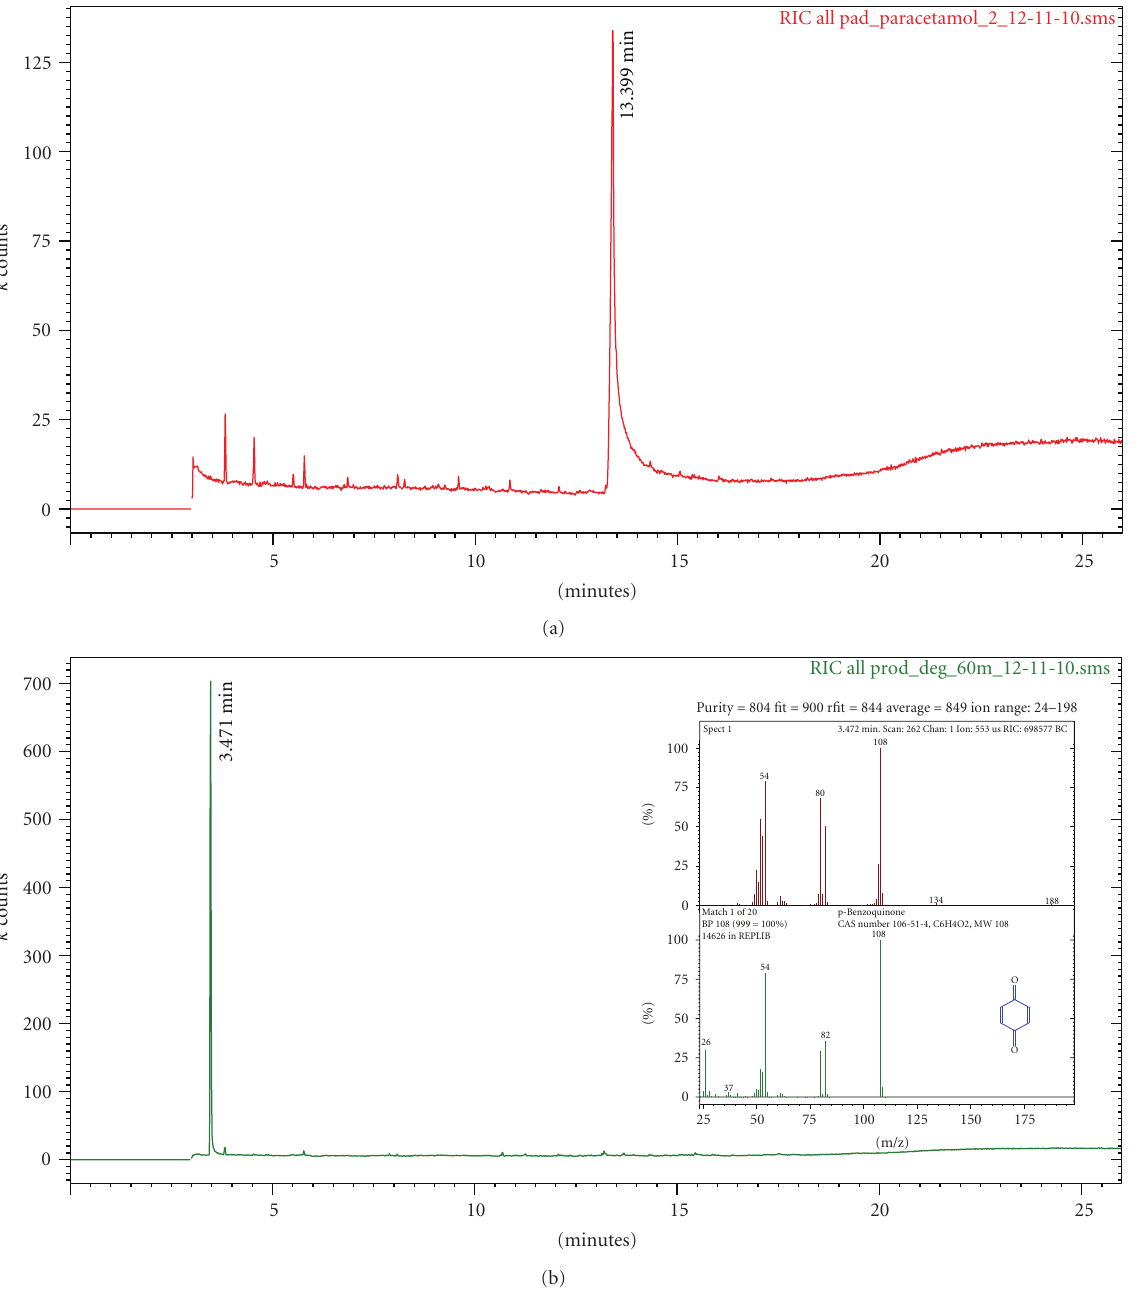
Figure 9: (a) GC chromatogram obtained for standard paracetamol solution in dichloromethane. C paracetamol = 0 . 2mgmL − 1 . (b) GC chromatogram obtained for the electrochemical degradation product of paracetamol after dichloromethane extraction of the sample collected after 60 minutes of electrolysis. Inset: comparison of the mass spectra obtained experimentally with one shown by the library NIST